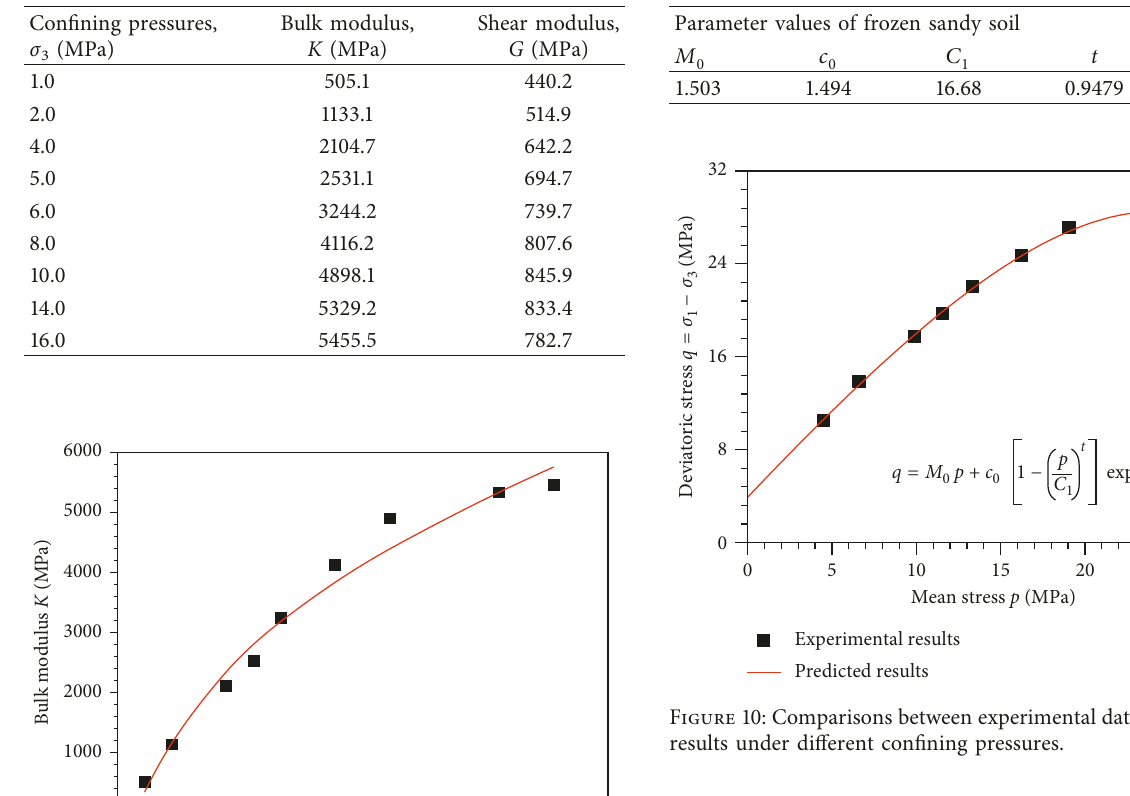
Table 2: Parameter determination of the strength criterion.